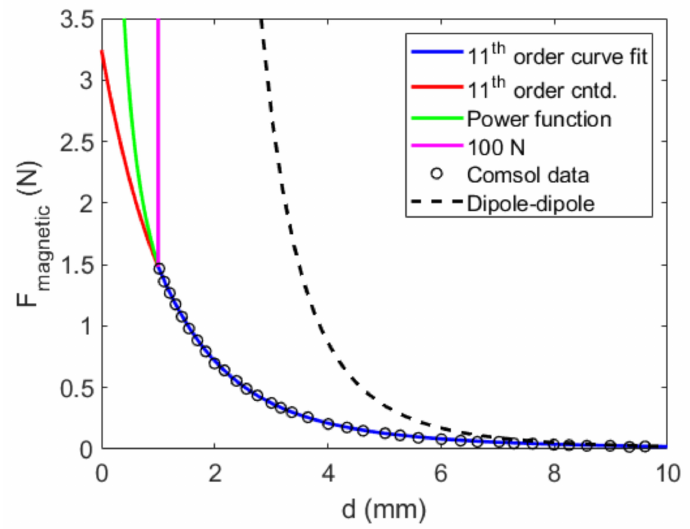
Figure 5. A comparison of magnetic force expressions versus gap size between the